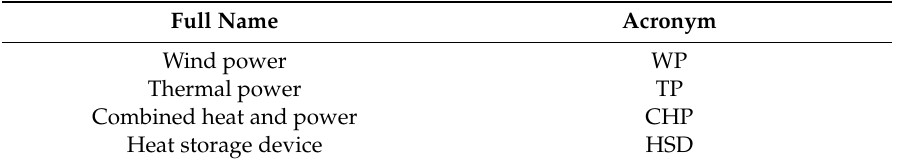
Table A1. Table of full names and acronyms.